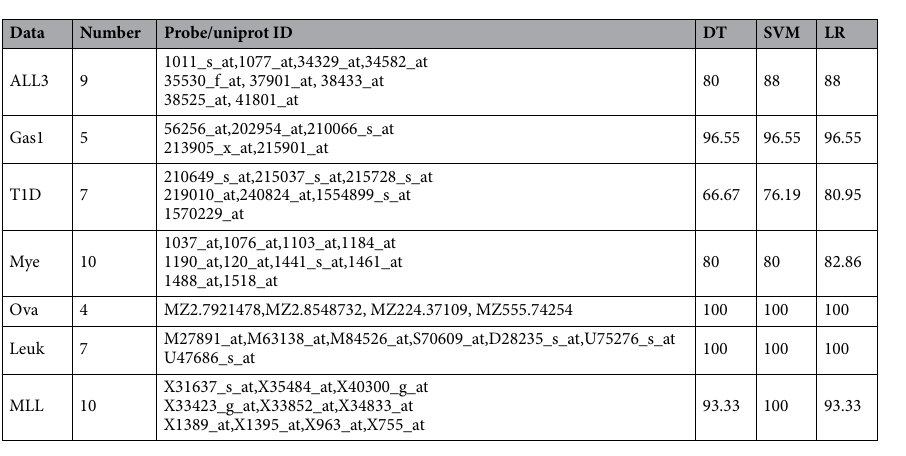
Table 6. Optimal subset of genes selected by the